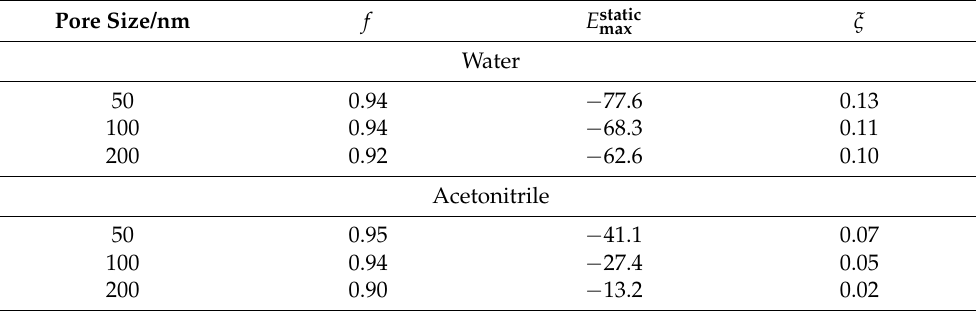
Table 3. ODNP parameters of synthesized CPG radical matrices of the type CPG-PEI25000-GT. E static max values are calculated from static ODNP measurements that are dependent on microwave power with extrapolation to infinite microwave power. Coupling factors were estimated with the assumption of saturation factors equal to 1 and are also